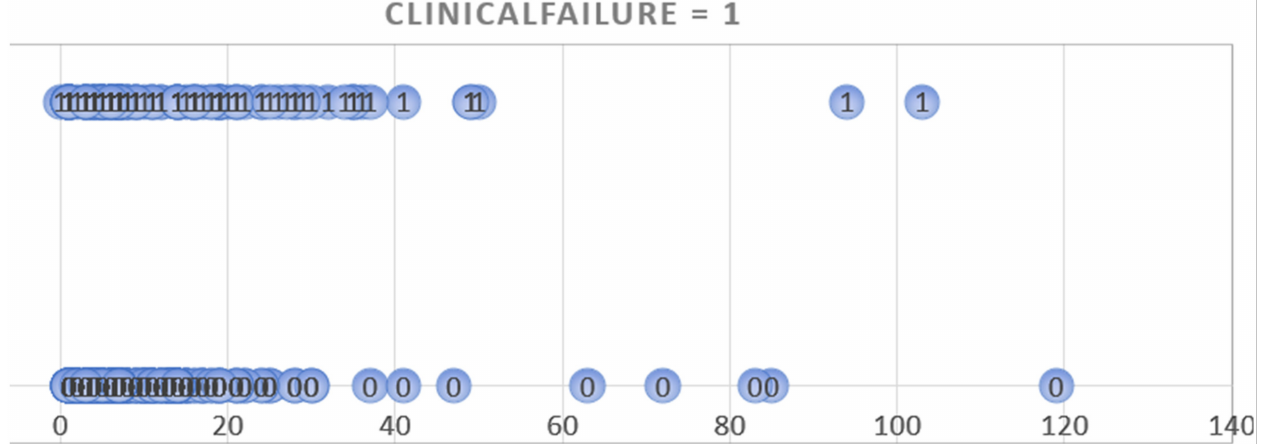
Figure 1. Graphic plotting of the duration of parenteral antibiotic treatment (horizontal axis; in days) against the occurrence of clinical failure (circles with the number 1) or remissions (circles with the number 0). The bulk of both, failures and remissions, situates in the left part of the figure, i.e., within a few days of parenteral therapy.